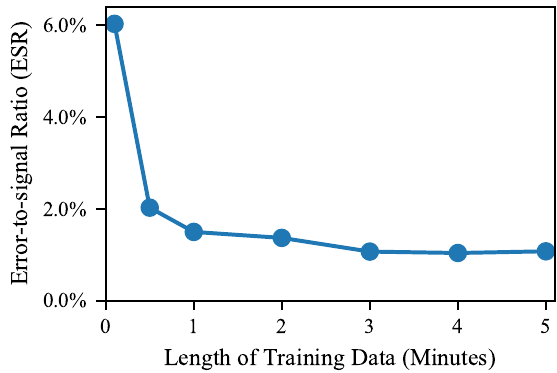
Figure 8. The validation energy-to-signal ratio (ESR) with different amounts of training data. The validation loss decreases as the amount of training data is increased from 10 s to 3 min.